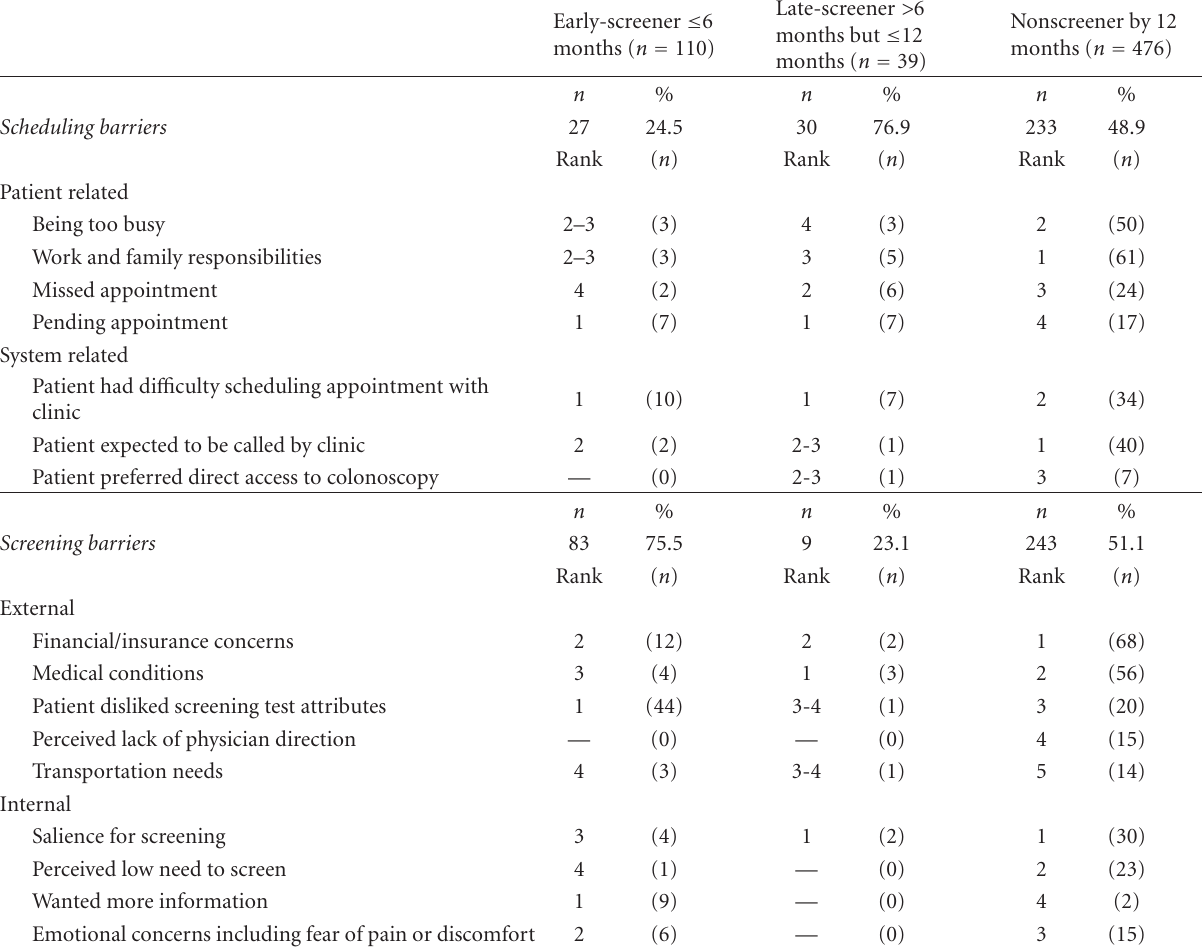
Table 2: Types of scheduling and screening barriers reported by early-, late-, and nonscreeners ( n =